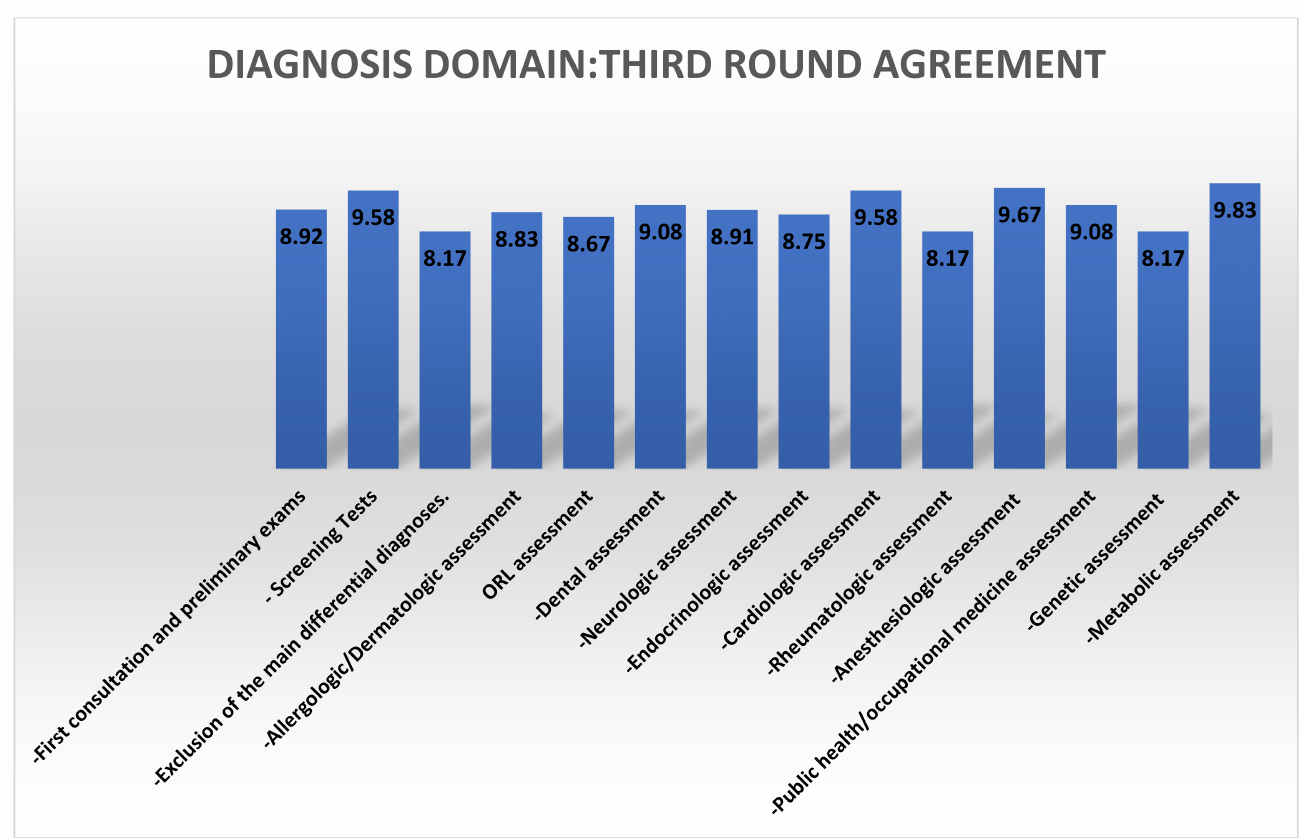
Figure 2. Third round agreement summary for the diagnosis